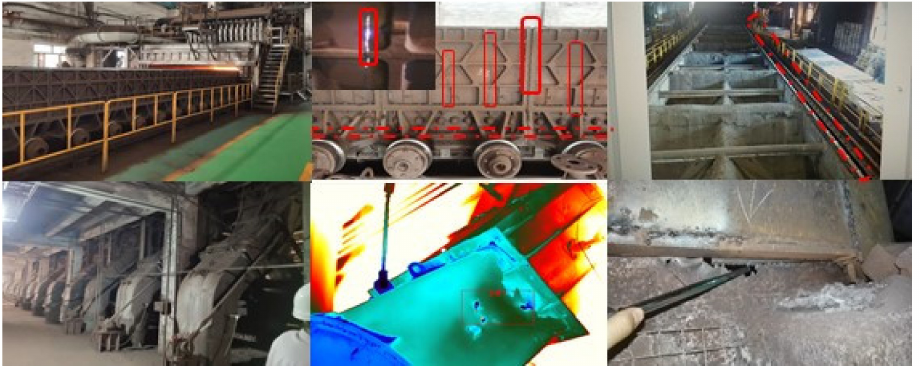
Figure 2. Some typical leakage in region